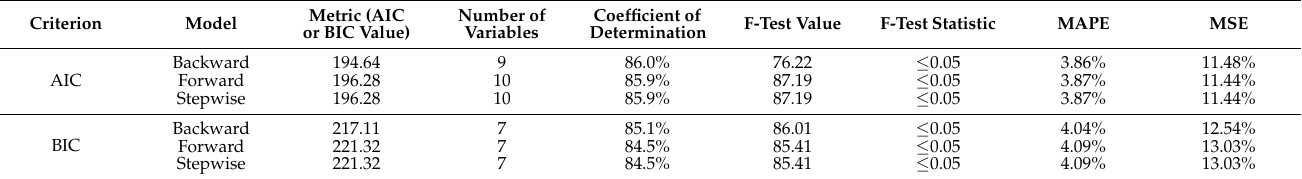
Table 6. Results from stepwise regression.